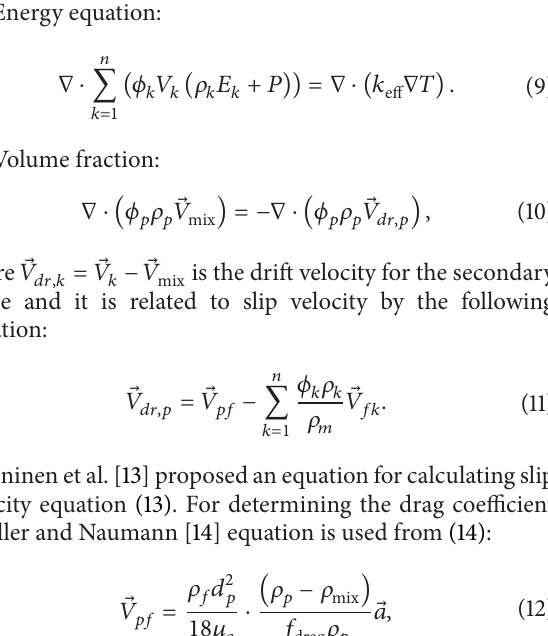
Figure 2: Different grids for independency of